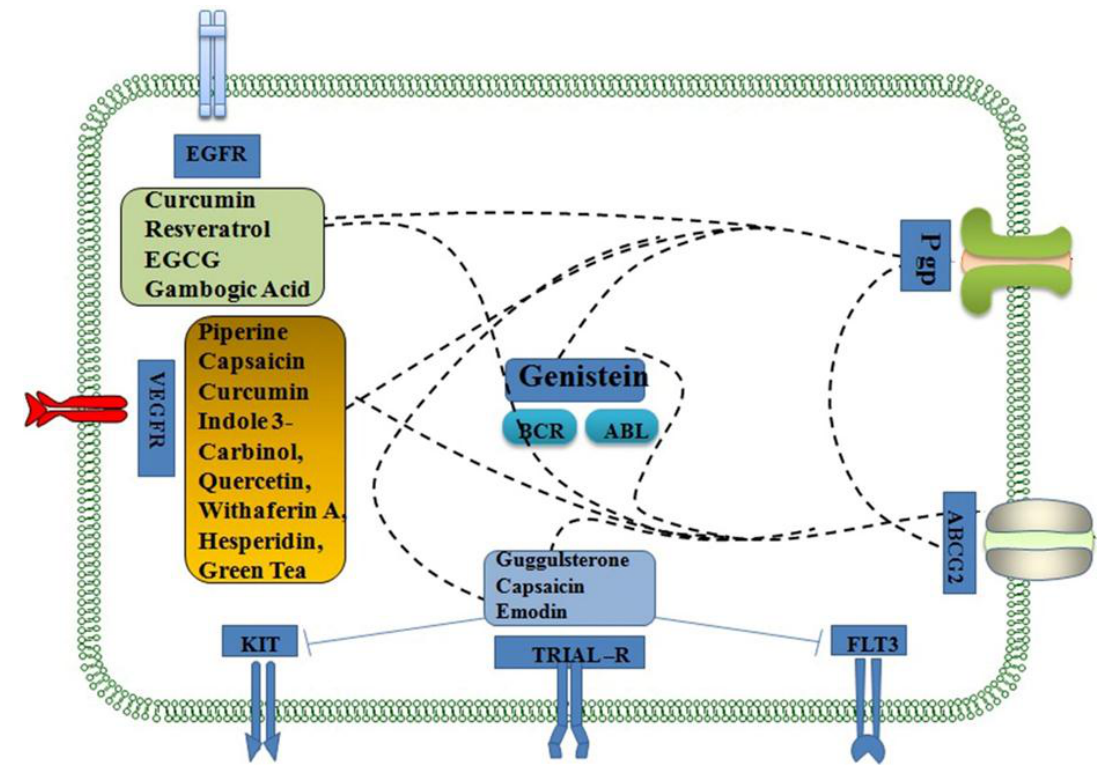
Figure 2. Selected targets of South Asian phytochemicals linked to chemosensitization. The indicated compounds in colored boxes interact with cell surface ABC transporters such as P-gp, ABCG2, and receptor tyrosine kinases including TRIAL-R, FLT3, KIT, VEGFR and EGFR. Some of the medicinal compounds also interact with intracellular tyrosine kinases (BCR-ABL kinase). The dashed lines indicate that the phytochemicals inhibit ABC drug transporters such as P-gp and ABCG2 resulting in chemosensitization. The solid lines depict inhibition of targets such as KIT and FLT3 resulting in chemosensitization.